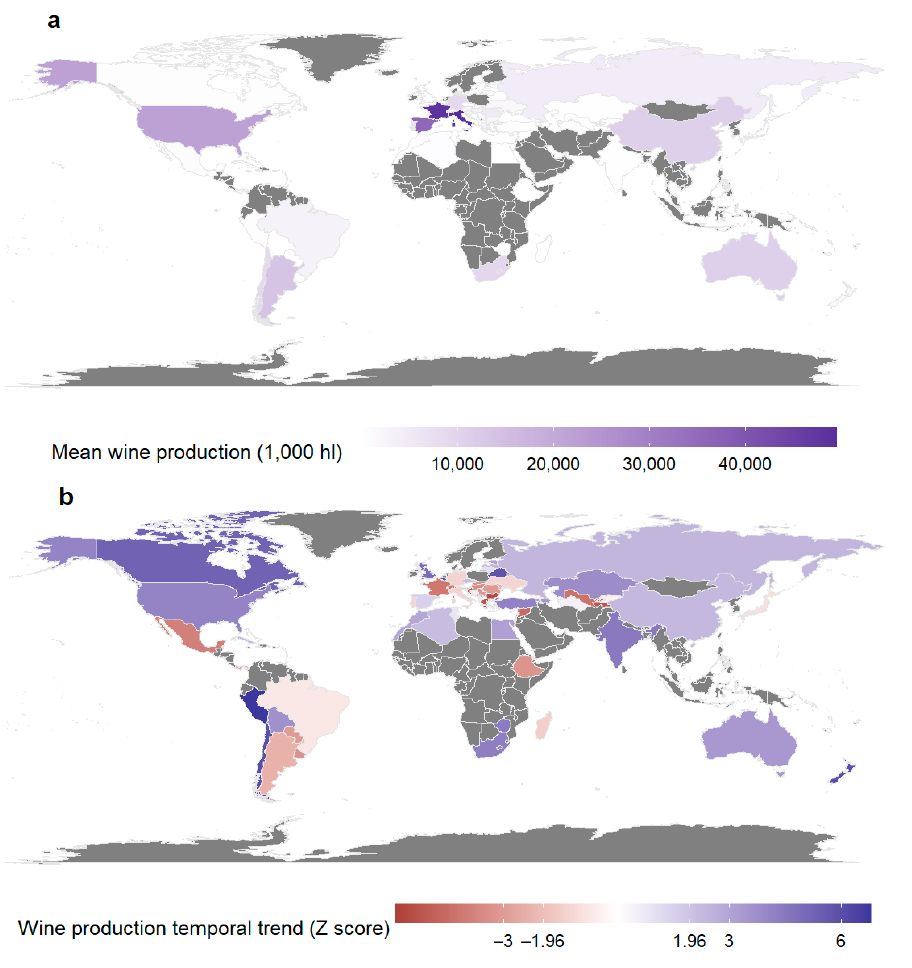
Figure 4. Wine production representation for each country, including mean long-term quantities ( a ); and Z-score for each country, signifying the extent of the temporal trend over 27 years ( b ). Countries in grey represent no data.